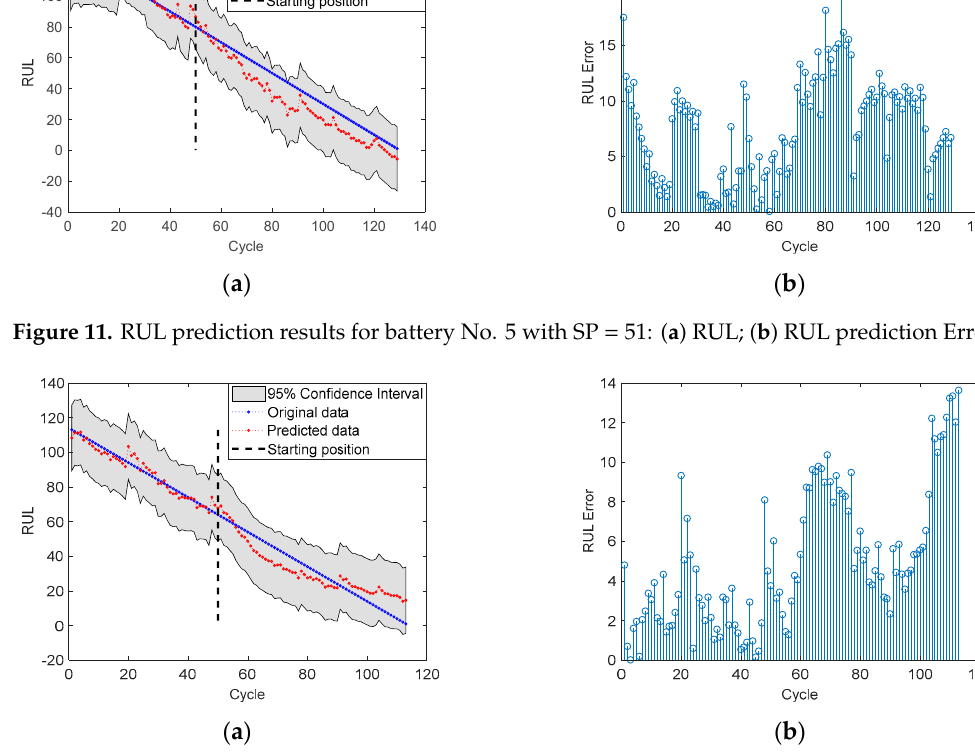
Figure 12. RUL prediction results for battery No. 6 with SP = 51: ( a ) RUL; ( b ) RUL prediction Error.